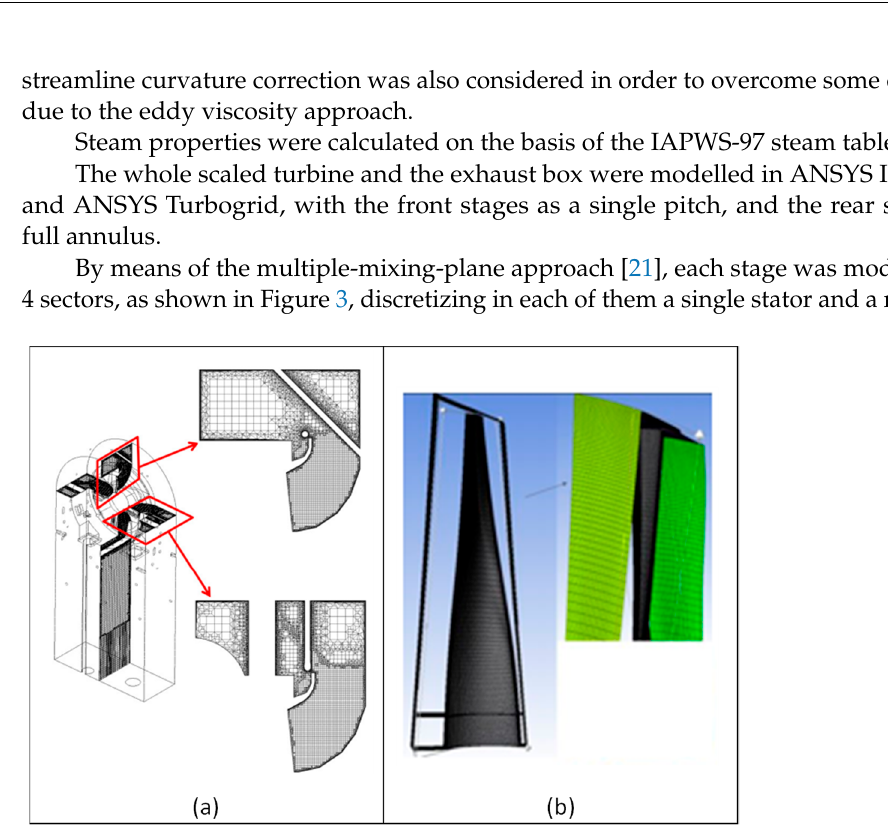
Figure 3. Grid details. ( a ) Multiple mixing plane at the interface between the LSMB and the diffuser and ( b ) last-stage moving blade discretization [19].